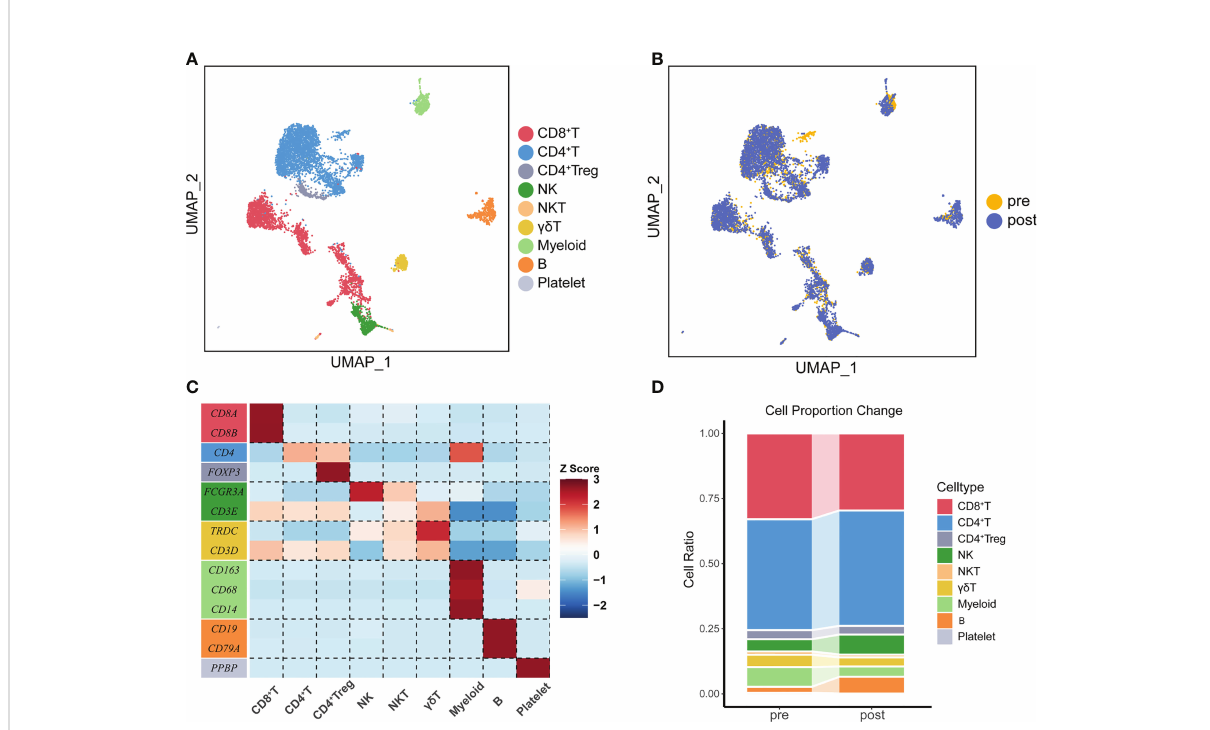
FIGURE 2 The immune landscape of PBMCs from patients treated with ATHENA. (A) Uniform manifold approximation and projection (UMAP) of all PBMCs before and after therapy. Cells are colored based on 9 clusters de fi ned by k-means clustering, which include the CD8 + T cell cluster, CD4 + T cell cluster, CD4 + Treg cell cluster, NK cell cluster, NKT cell cluster, gd T cell cluster, Myeloid cell cluster, B cell cluster and Platelet cell cluster. (B) UMAP of all PBMCs, colored according to ATHENA treatment history. (C) The expression patterns of canonical markers in distinct immune cell clusters. (D) Sankey diagram showing the percentage of cells per sample for clusters before and after